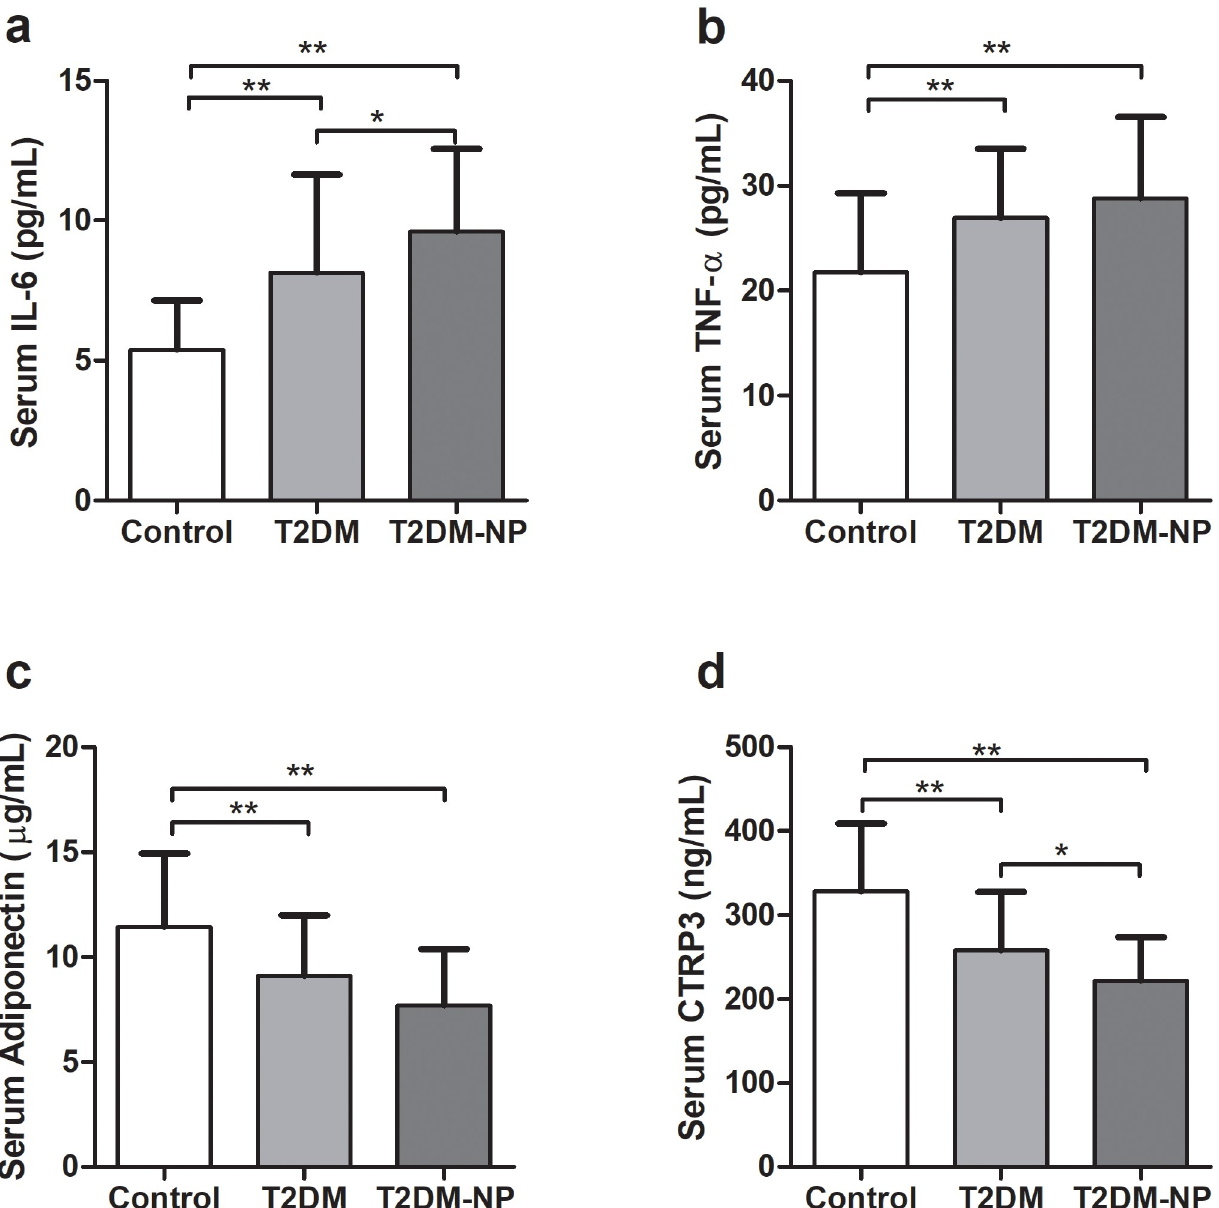
Fig 1. Serum levels of cytokines and adipokines in the studied groups. a) Serum levels of IL-6, b) Serum levels of TNF- α , c) Serum levels of adiponectin and d) Serum levels of CTRP3. � p < 0.05 and �� p < 0.01.